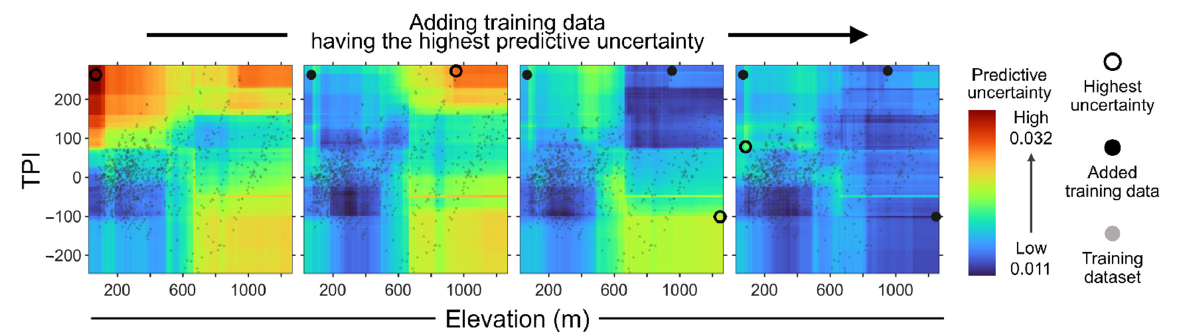
Figure 8. Examples of adding training data and changes in predictive uncertainties. Predictive uncertainties decreased when additional training data were used. Note that the 2D imaginary soils used in this simulation had the same characteristics, apart from the two variables of interest (elevation and TPI), which makes the predictive uncertainty reduction appear radical.